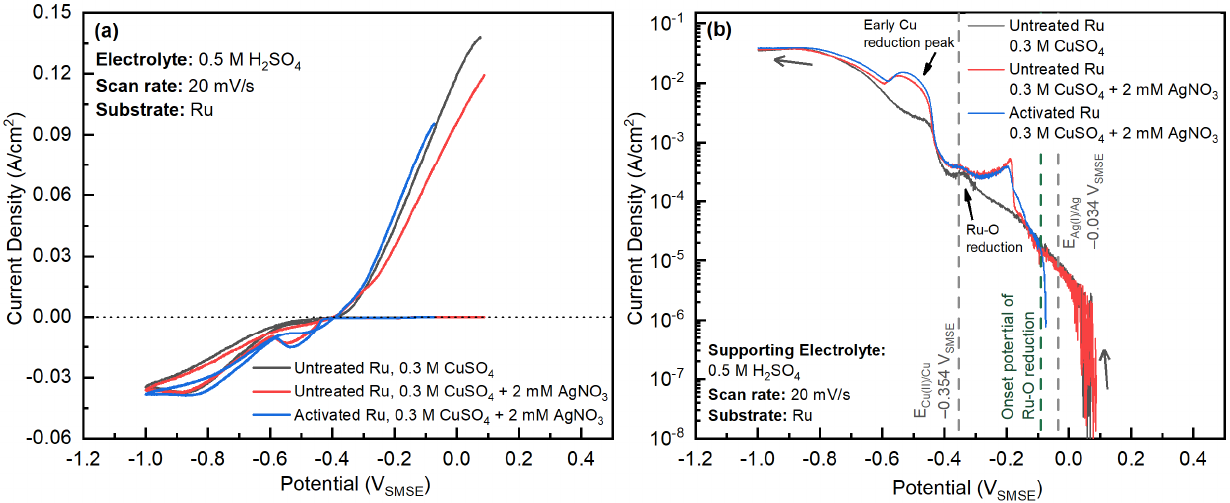
Figure 1. ( a ) Cyclic voltammograms from 0.3 M CuSO 4 + 0.5 M H 2 SO 4 with and without addition of 2 mM AgNO 3 at activated or pristine Ru substrates [36]. Note that the Figure 1 ( b ) shows the current of the cathodic scans in log-scale.